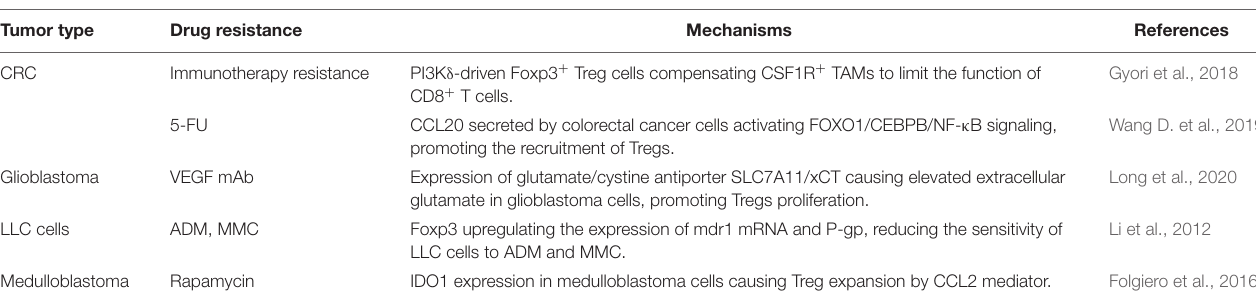
TABLE 4 | Mechanisms of antitumor drug resistance mediated by